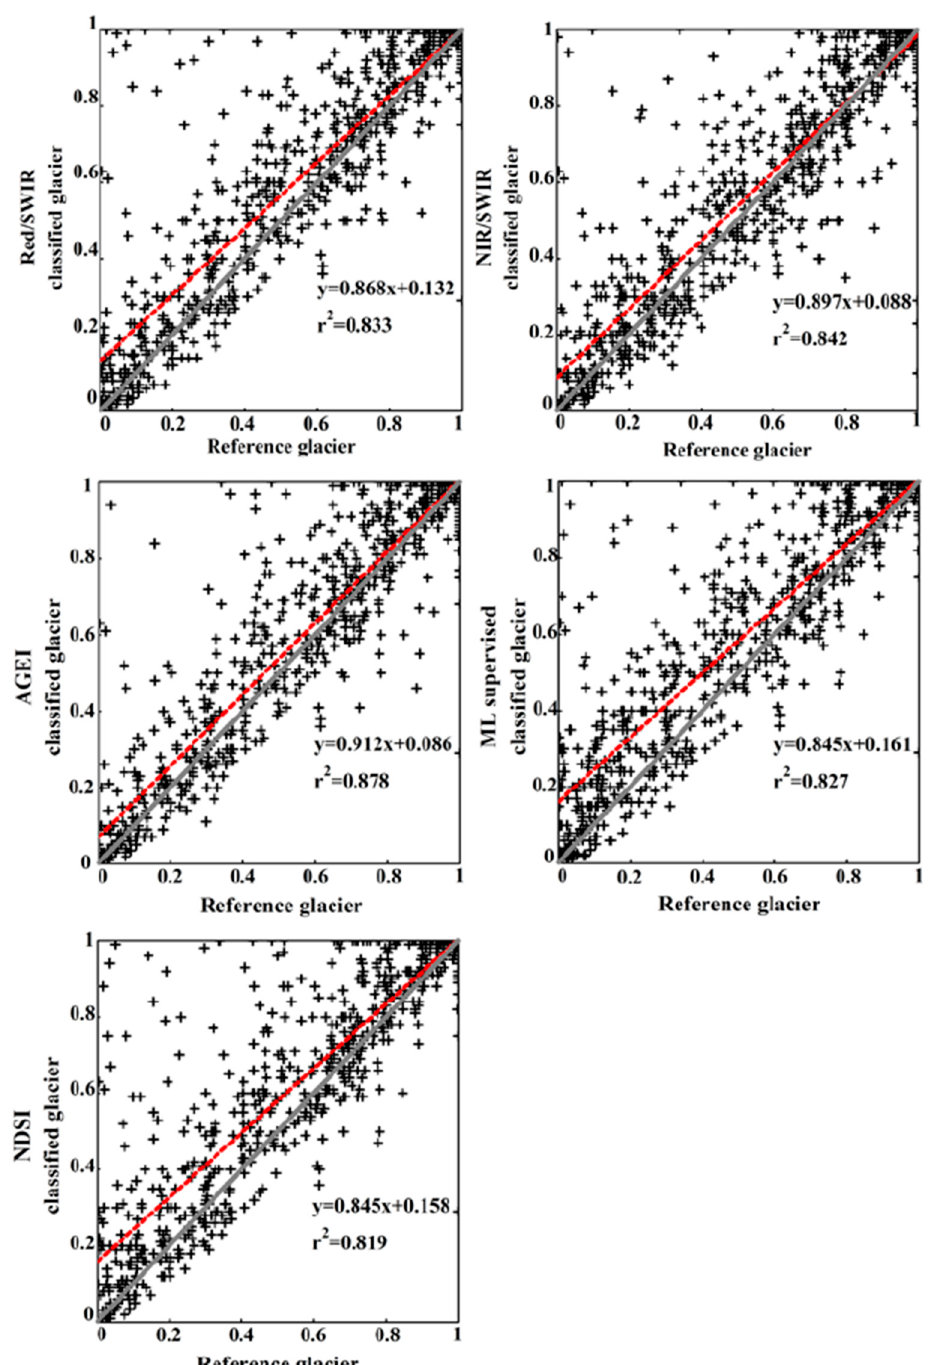
Figure 10. The relationship between reference glacier and classified glacier calculated for each classifier after applying optimum thresholds (Table 3) for the 1120 validation plots. Grey lines are 1:1 lines, and red dashed lines are from the ordinary least squares regression.